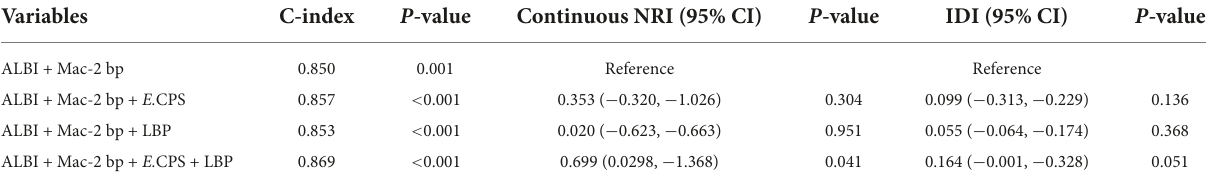
TABLE 4 Comparison of basic models and models adding factors for predicting favorable prognosis and excellent